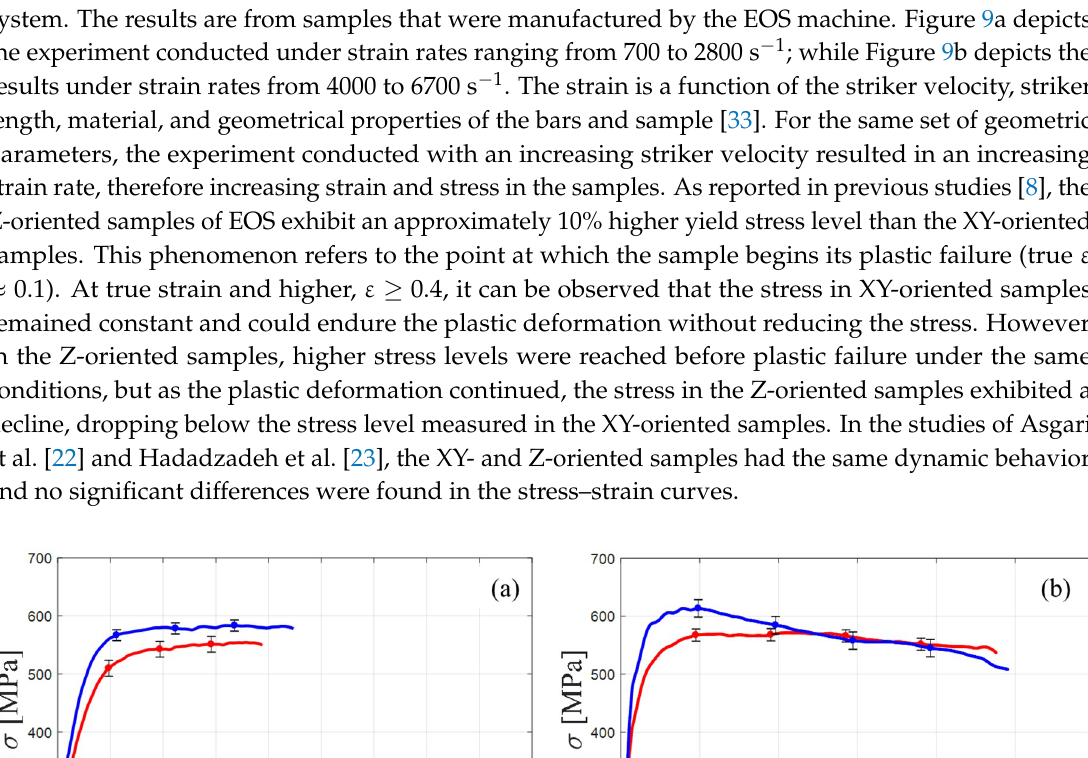
Figure 10. CL samples’ mean value and standard deviation (STD) of true stress–true strain curves: ( a ) comparison between XY- and Z-oriented samples at true strain rate range of 700 to 2800 s −1 ; ( b ) comparison between XY- and Z-oriented samples at true strain rate range of 4000 to 6700 s −1 . To characterize the effect of the manufacturing on the dynamic behavior, this study implemented a comparison between the manufactures attributed to the building orientation and strain rate. Figure 11a,c depicts comparisons of the strain rates in the range of 700 to 2800 s −1 for the Z and XY orientations, respectively. In the presented strain rate range, a comparison between the two sample types (EOS and CL) revealed no significant difference in the strain–stress curves regarding the building orientation. This is valid up to a true strain of 0.5, as observed in Figure 11a for the Z orientation and in Figure 11c for the XY orientation (both under strain rates of 700 to 2800 s −1 ).